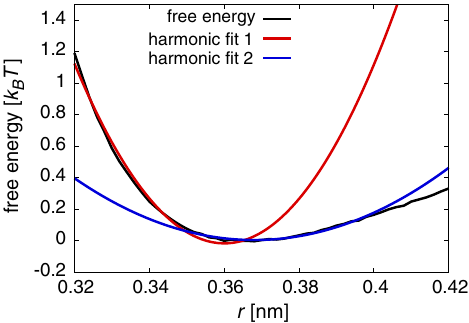
FIG. 8. The free energy F ð r Þ associated with the distance r between the methane and surrounding water molecules together with a harmonic fit to the repulsive part (red line) and a harmonic fit around the free energy minimum (blue line).